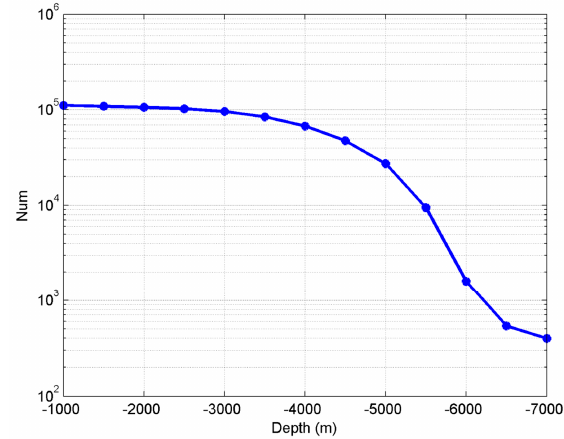
δ Figure 10. Accuracy of the new version of δ g with varying water depth: ( a ) Error mean values; ( b ) Figure 10. Accuracy of the new version of g with varying water depth ： ( a ) Error mean values; ( b ) δ with varying water depth ： ( a ) Error mean values; ( b ) error STD values. Figure 10. Accuracy of the new version of g error STD values. error STD values.